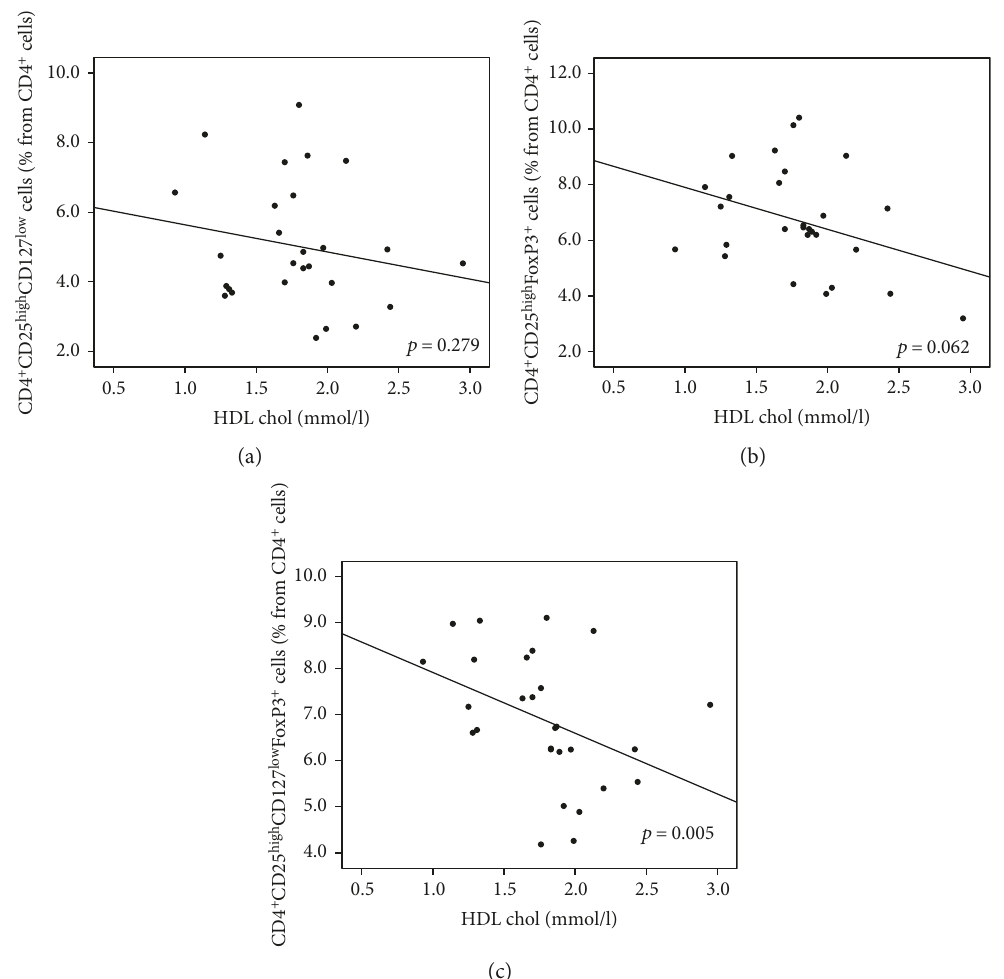
Figure 6: (a – c) The relationship between T regulatory cells and HDL level. Higher level of HDL cholesterol correlated with lower Treg numbers. This correlation was signi fi cant in the case of CD127 low FoxP3 + cells ( p = 0 005 , R = − 0 52 ). The same trend was observed for both CD127 low and FoxP3 + Treg cells but failed to reach signi fi cant levels ( p = 0 279 and R = − 0 216 for CD127 low Treg cells and p = 0 062 and R = − 0 357 for FoxP3 + Treg cells). (a) CD127 low Treg cells (% from CD4 + cells). (b) FoxP3 + Treg cells (% from CD4 + cells). (c) CD127 low FoxP3 + cells (% from CD4 +